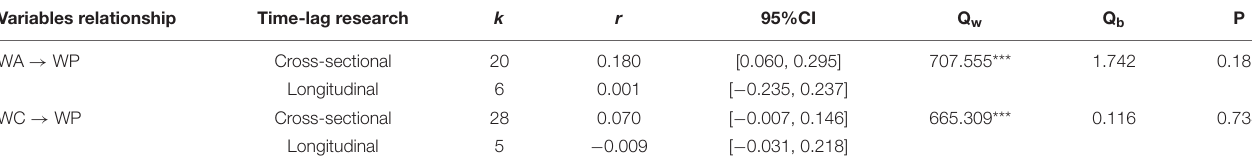
TABLE 8 | Moderator effect of the time-lag research on the relationship between workaholism and work performance. Variables